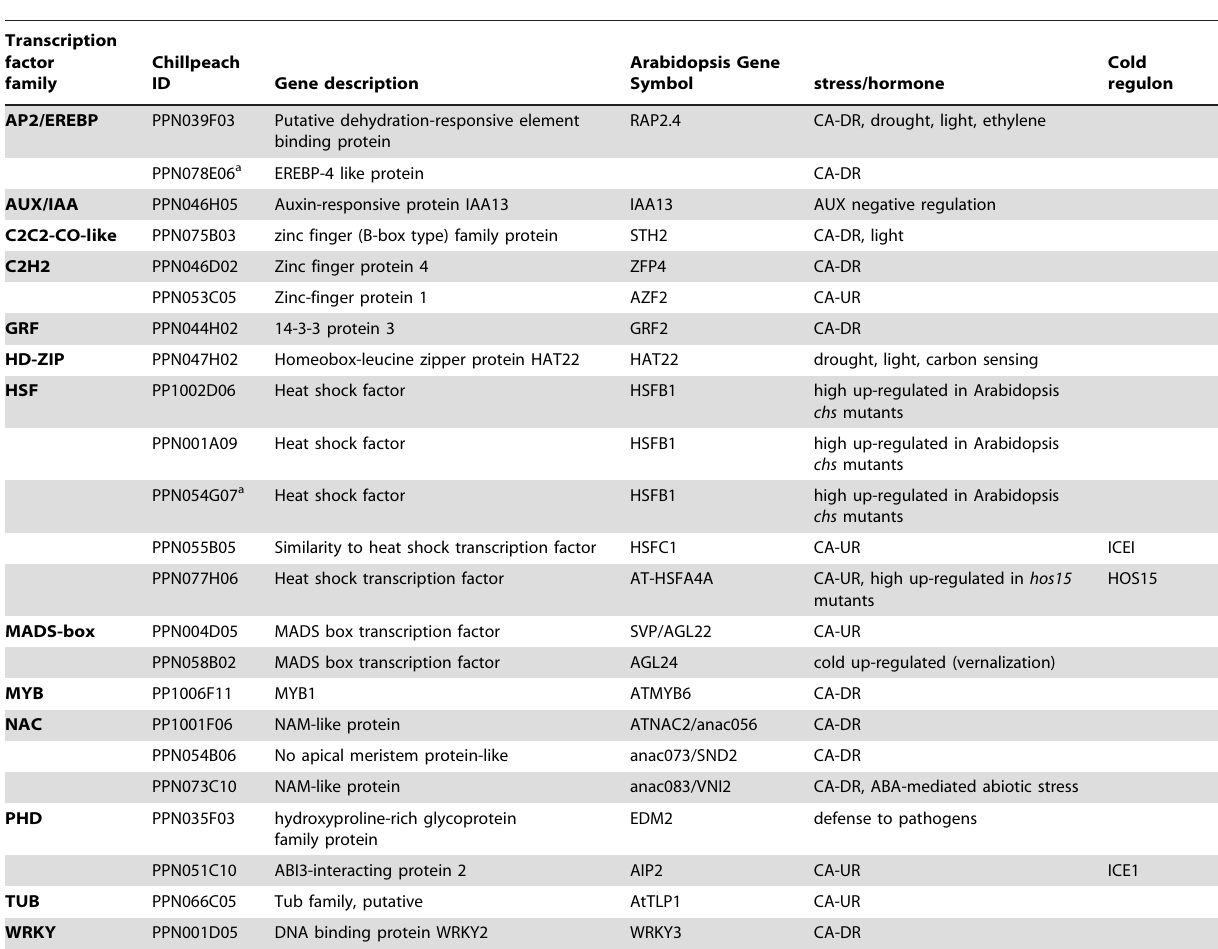
Table 1. Transcription Factors genes common Cold-Upregulated in Peach with Stress and Hormone Related